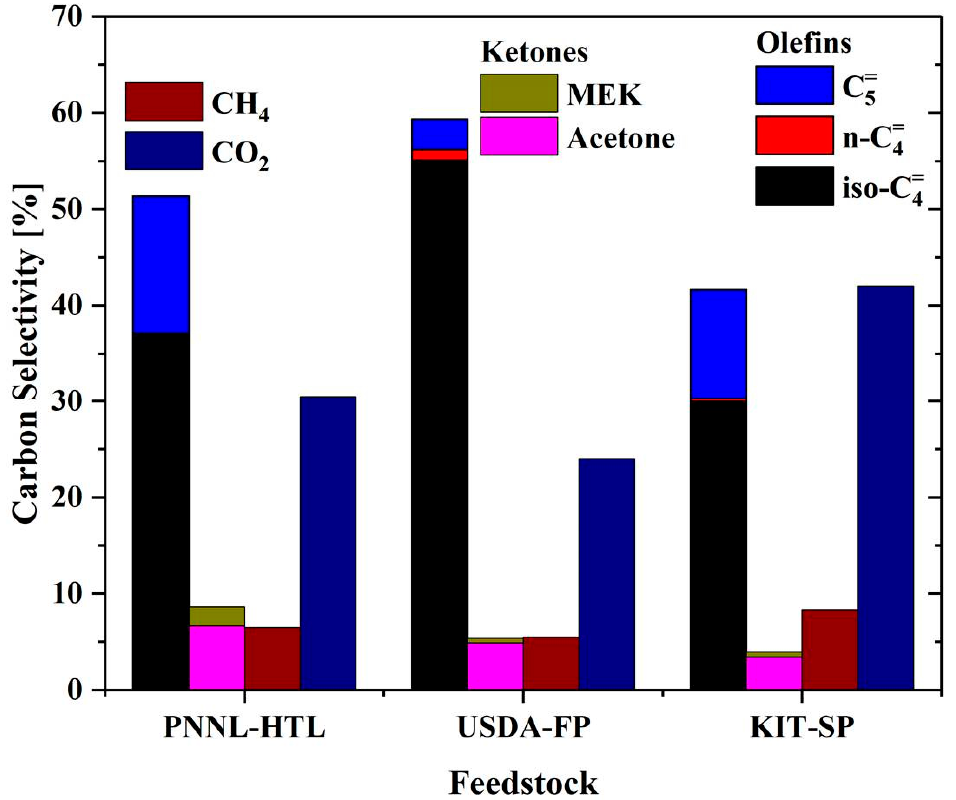
Figure 3. Major product selectivity of all feedstocks. Temperature: 450 ◦ C, GHSV: 1200 h − 1 , catalyst loading 0.7 g, N 2 50 vol%, S / C = 2.8, 11.2, 4.7 for PNNL-HTL, USDA-FP, and KIT-SP, respectively. The product selectivity was measured at 100% conversion of carboxylic acids.